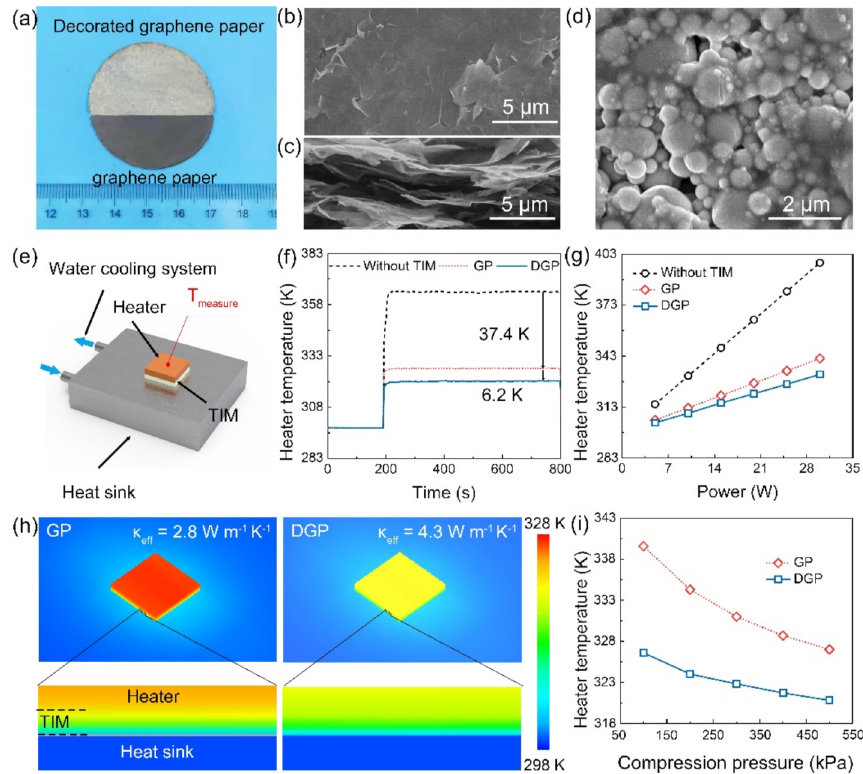
Figure 3. ( a ) Image of decorated graphene paper (top) and pristine graphene paper (bottom). ( b ) Top view and ( c ) cross-sectional SEM images of GP. ( d ) Top view SEM image of DGP. ( e ) Schematic configuration of the TIM performance measurement system and packaging of the applied TIM using vertical compression (500 kPa). ( f ) Temperature evolution of the heater as a function of heating time at a heater power of 20 W. ( g ) Various applied powers after heating for 600 s. ( h ) Comparison of heat dissipation capability based on simulated profiles of GP and DGP. ( i ) Temperature of the heater as a function of the applied compression